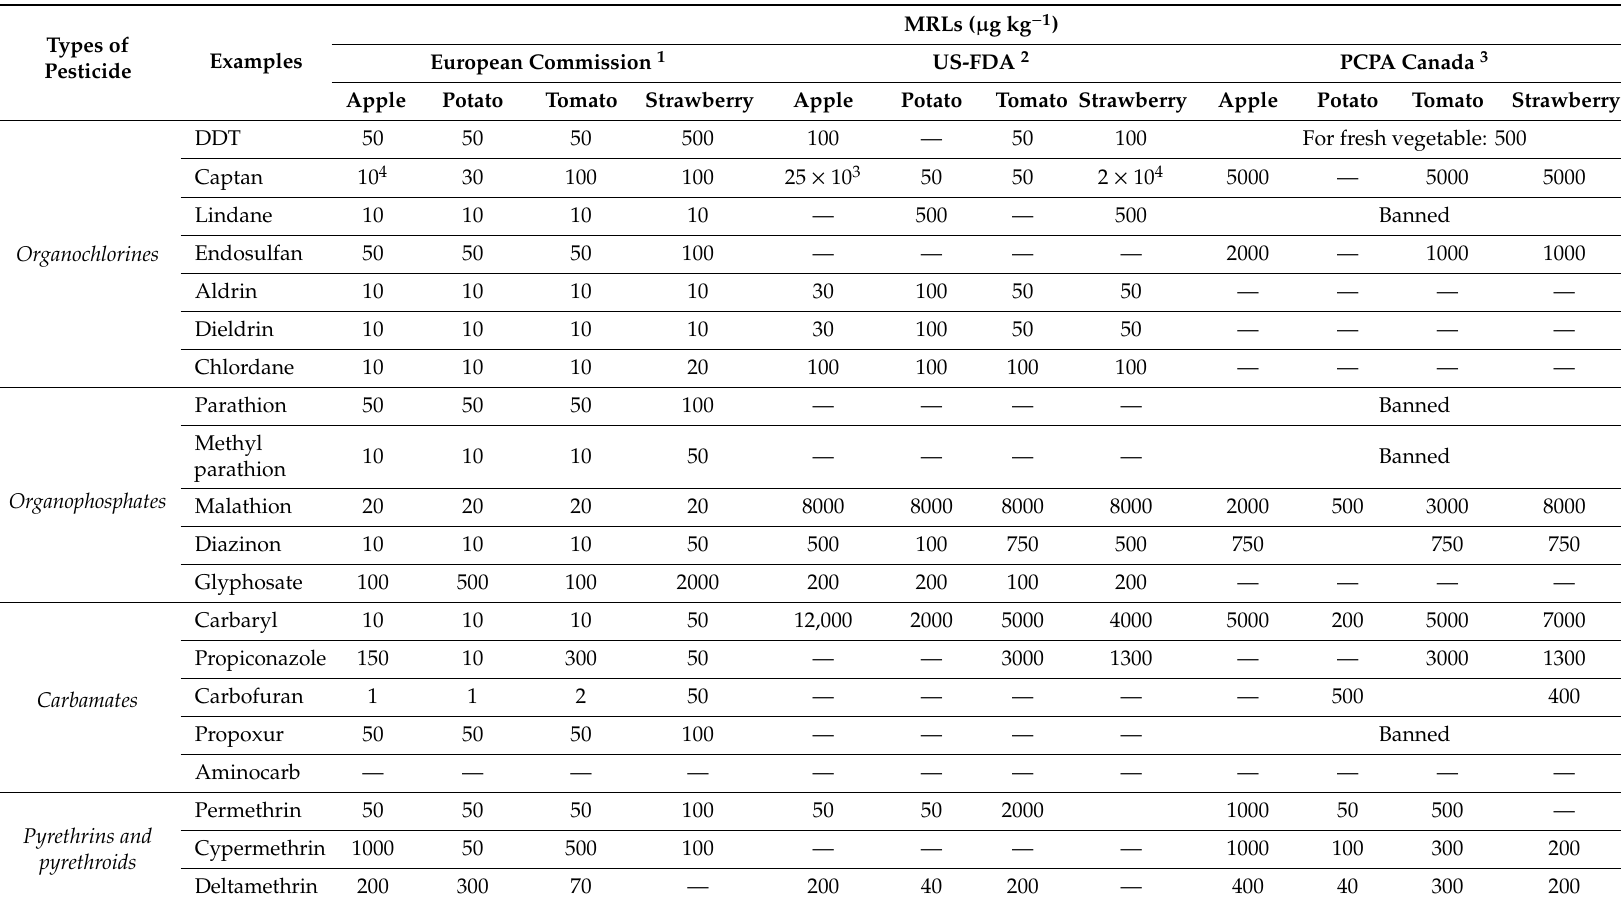
Table 5. Maximum residue limits (MRLs) for fruits and vegetables in Europe, the United States and Canada. Types of Pesticide Examples